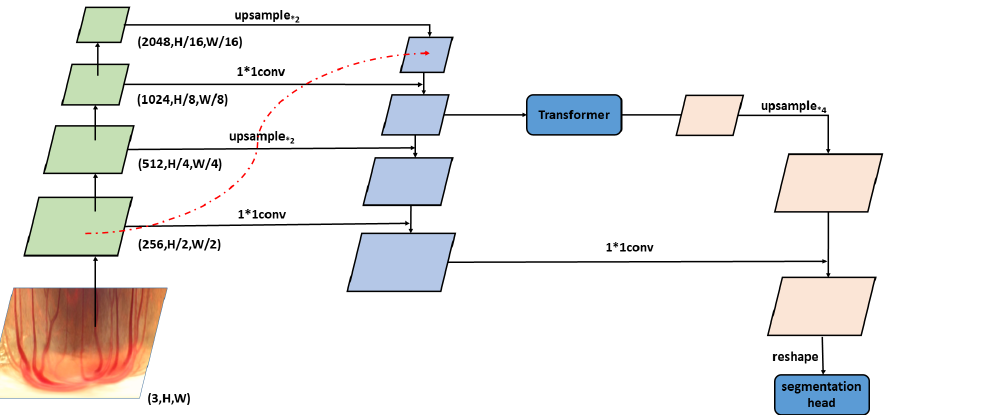
Figure 4. An overview of the CNN-transformer